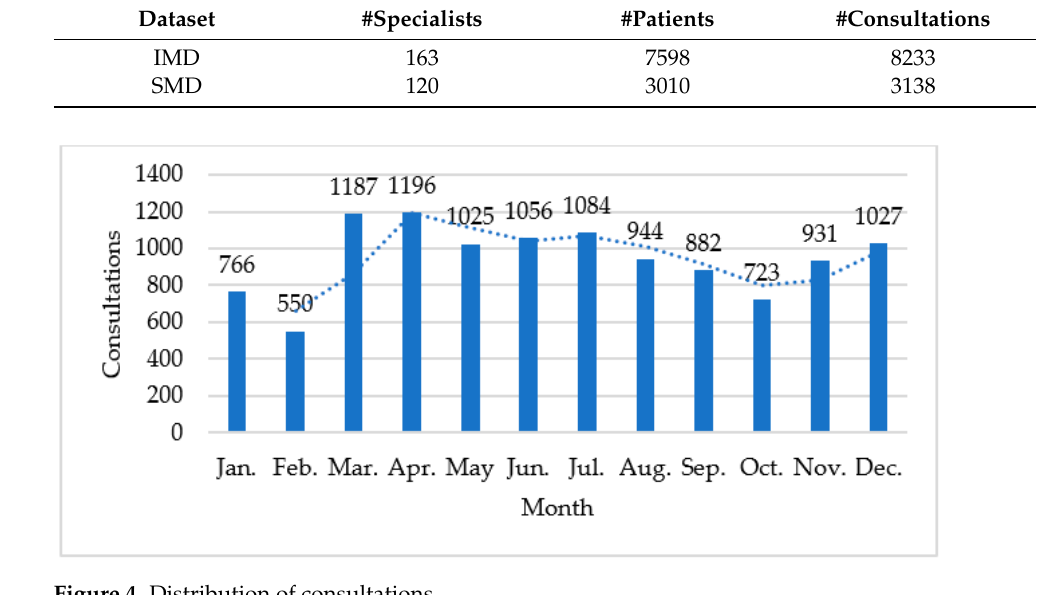
Figure 4. Distribution of